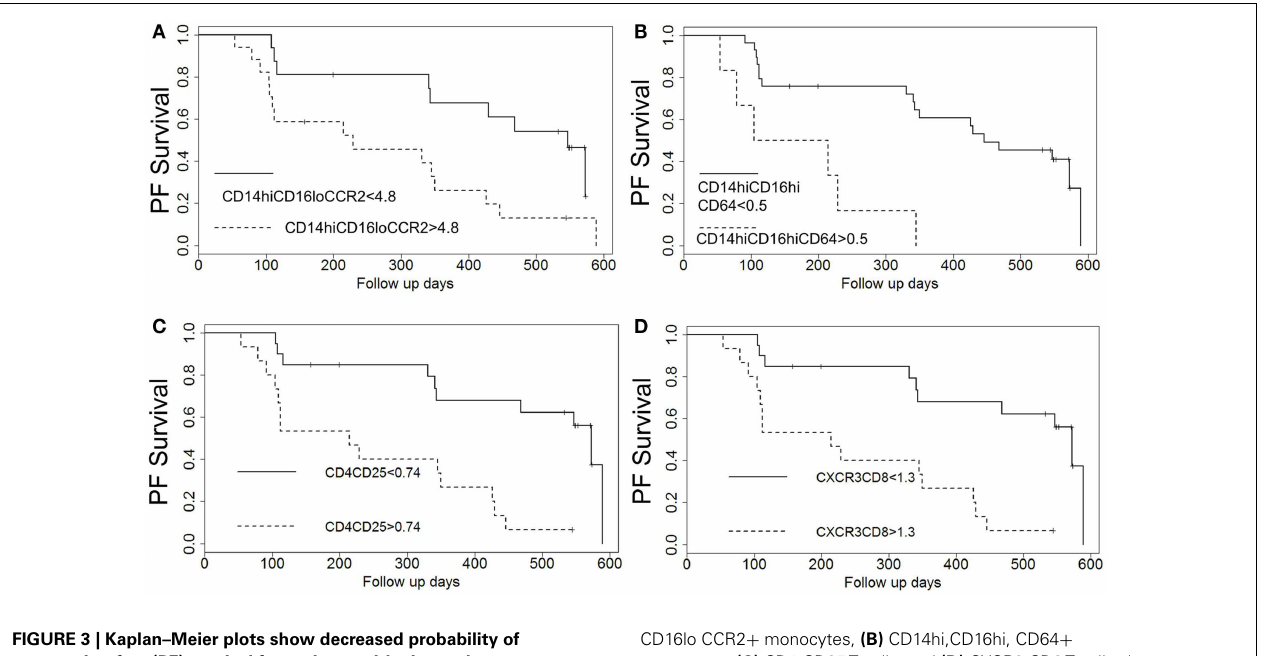
FIGURE 3 | Kaplan–Meier plots show decreased probability of progression-free (PF) survival for patients with elevated percentages ofT cell and monocyte subsets above identified thresholds . Patients with elevated percentages of (A) CD14hi